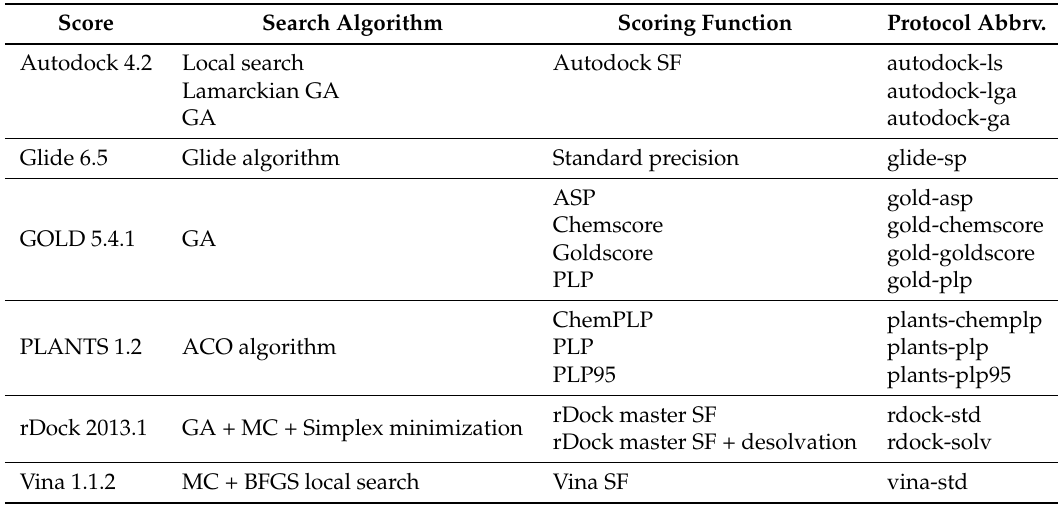
Table 3. Docking protocols, search algorithms, and scoring functions considered in this